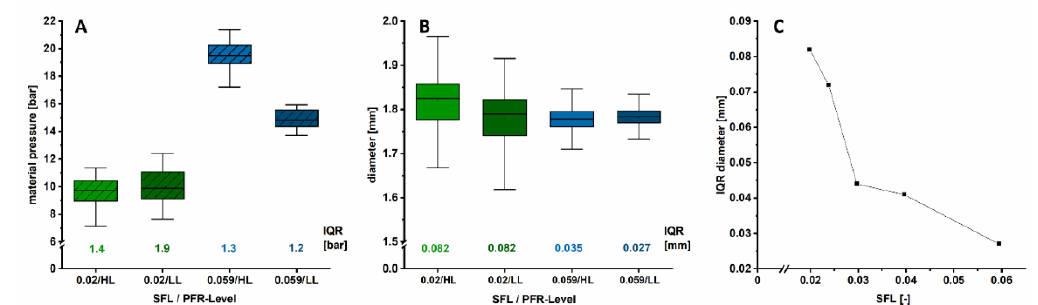
Figure 7. Boxplots of inline determined material pressure ( A ) and diameter ( B ) during HME for two different applied SFL on a high (10 g/min, HL) and low (5 g/min, LL) PFR-level, respectively (1 Hz, n > 290). IQRs of pressure and diameter are indicated. ( C ) displays diameter IQR as function of different applied screw speeds ( n > 290).